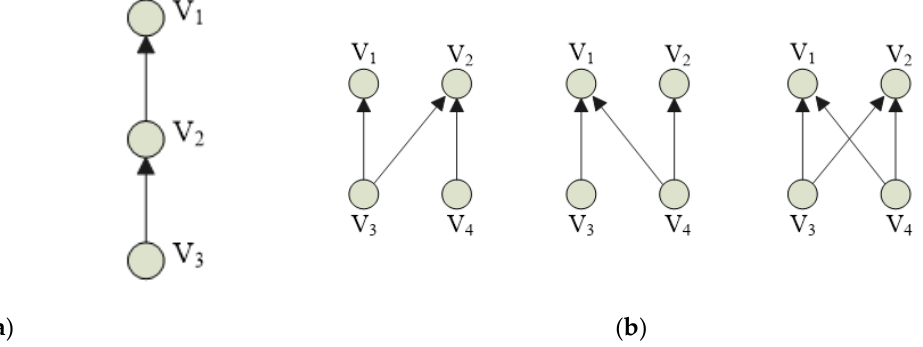
Figure 1. Types of conflicts. ( a ) Direct conflict, ( b ) Indirect conflict. Direct conflict: Two links with common nodes are assigned the same time slot. Because the node is working in half-duplex mode, it can neither send nor receive at the same time nor can it receive messages sent by multiple nodes at the same time. Indirect conflict: Two links are assigned the same time slot and channel and the receiving end of either link is within the sending range of the other